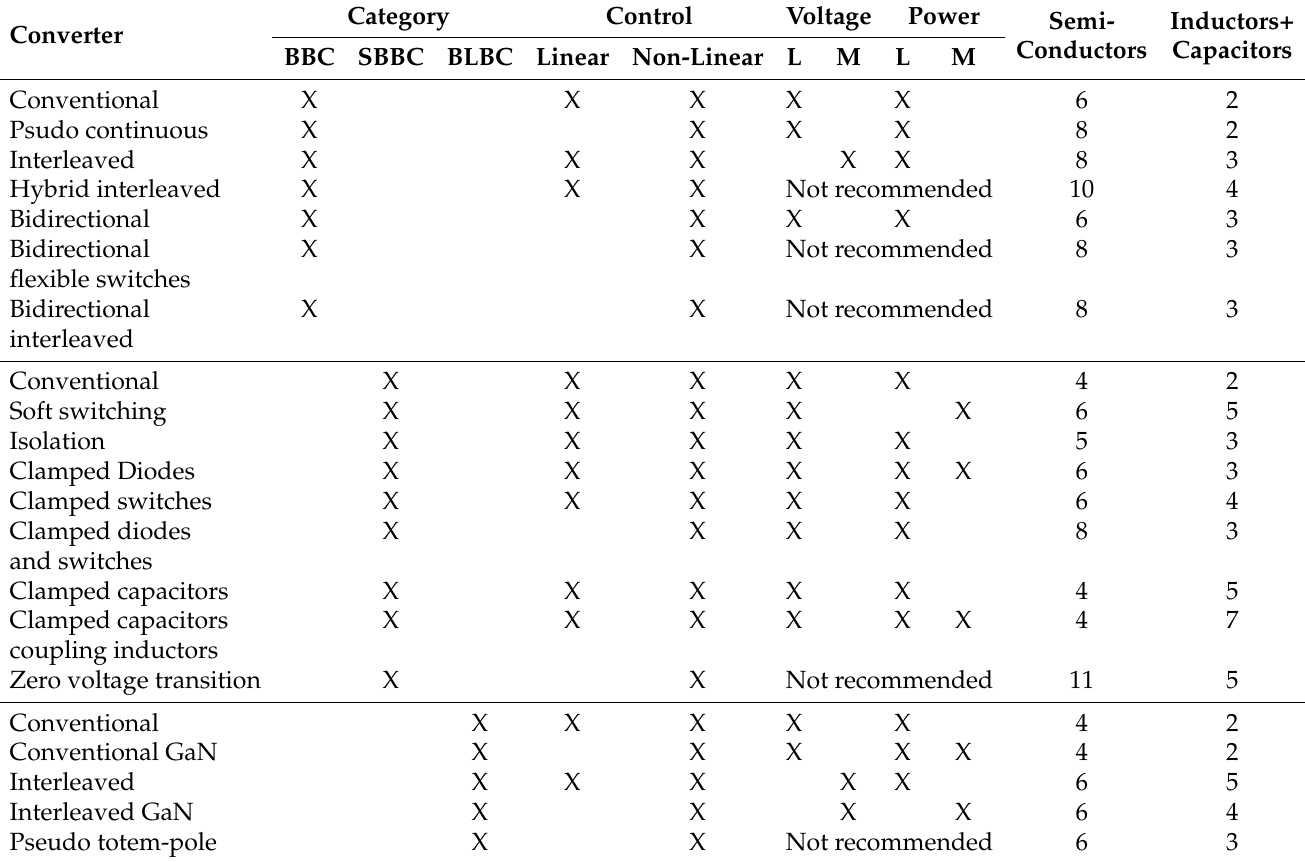
Table 1. Summary and comparison among BBC, SBBC, and BLBC topologies categorized in this paper.